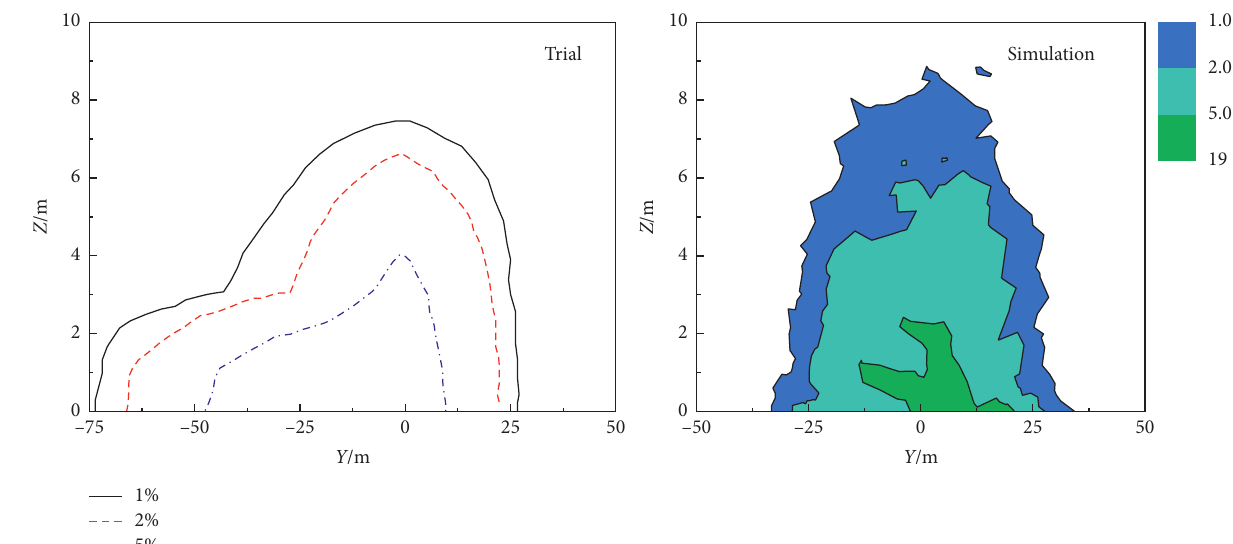
Figure 8: Comparison of Coyote 3 trial and Fluent simulation for LNG vertical volume-concentration distribution ( X � 140m and t � 100